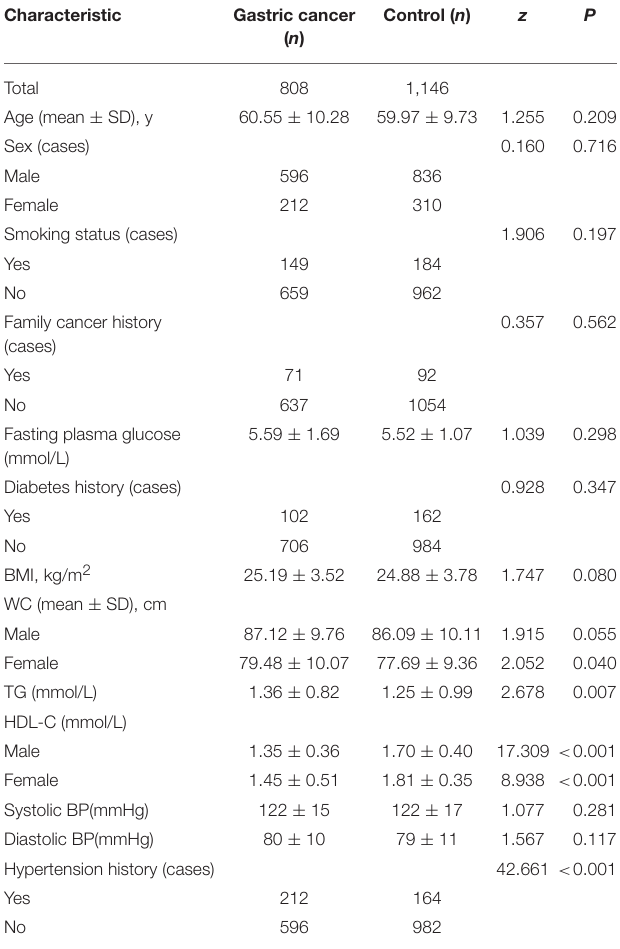
TABLE 1 | Baseline characteristics of gastric cancer patients and population-based controls. Characteristic